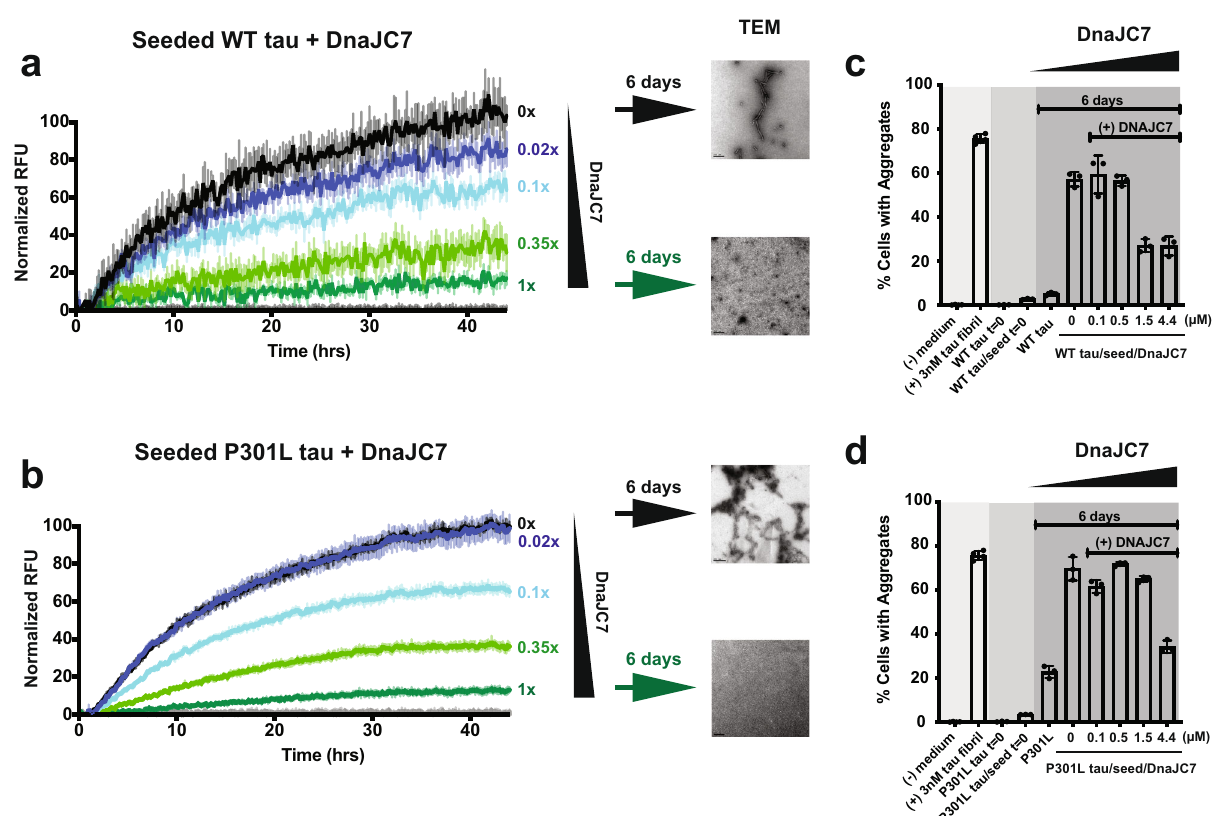
Fig. 4 DnaJC7 ef fi ciently suppresses tau aggregation in vitro. 4.4 µ M WT tau ( a ) and 4.4 µ M P301L tau ( b ) aggregation was induced using 50 nM tau monomer seeds in the presence of different DnaJC7 chaperone concentrations. Aggregation was monitored using ThT fl uorescence. Experiments were performed as technical replicates ( n = 3) and are shown as a mean with standard deviation. DnaJC7 concentrations ranged from 0X (0 μ M), 0.02X (0.1 μ M), 0.1X (0.5 μ M), 0.35X (1.5 μ M), to 1X (4.4 μ M) and are colored from black to green. Gray curves show negative controls: tau alone, DnaJC7 alone at each concentration, and tau monomer seeds alone. TEM images were taken at the end point to con fi rm the presence or absence of fi brils. Scale bar for each micrograph is 200 nm. ( c , d ) The endpoint and control samples of the in vitro aggregation experiment were assayed for seeding activity in tau biosensor cells. The in-cell aggregation assay shows signi fi cant reduction in seeding in the presence of DnaJC7 even after six days of incubation and is consistent with the in vitro measurements. Tau seeding experiments were performed as biological replicates ( n = 3) and are shown as mean with standard